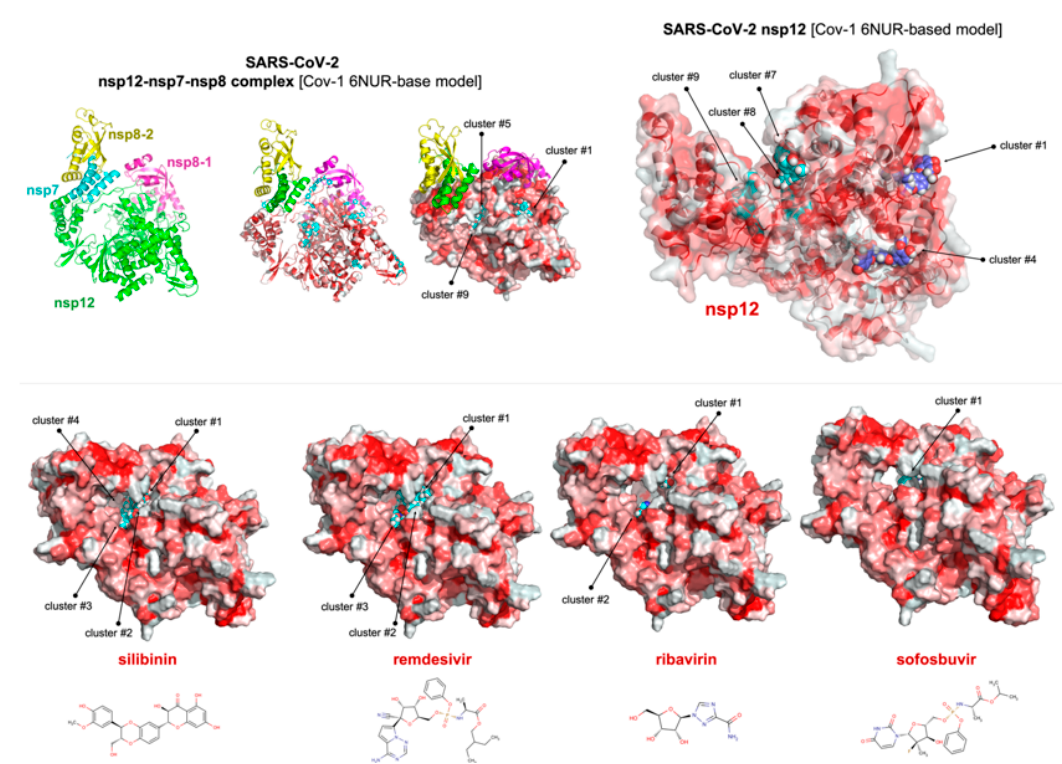
Figure 3. Silibinin is predicted to target SARS-CoV-2 viral polymerase RdRp (I). Representations of a SARS-CoV-1 6NUR-based homology model of the SARS-CoV-2 viral polymerase RdRp showing the computationally predicted locations of silibinin, remdesivir, ribavirin, and sofosbuvir clusters in the nsp12 catalytic subunit of the nsp12-nsp7-nsp8 complex. The protein has been represented as a function of the hydrophobicity of its surface amino acids and the Na + and Cl - ions have been eliminated to facilitate visualization. Figures were prepared using PyMol 2.3 software.